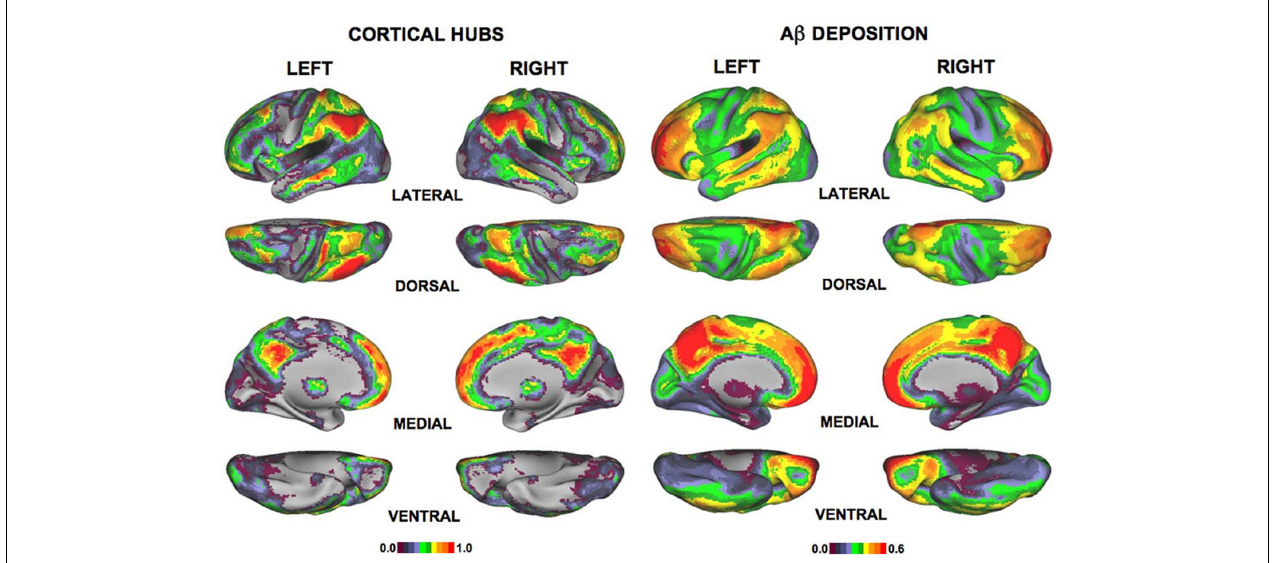
FIGURE 4 |The spatial distribution of functional brain hubs in normal controls (the two columns on the left) andA β deposition inAD (the two